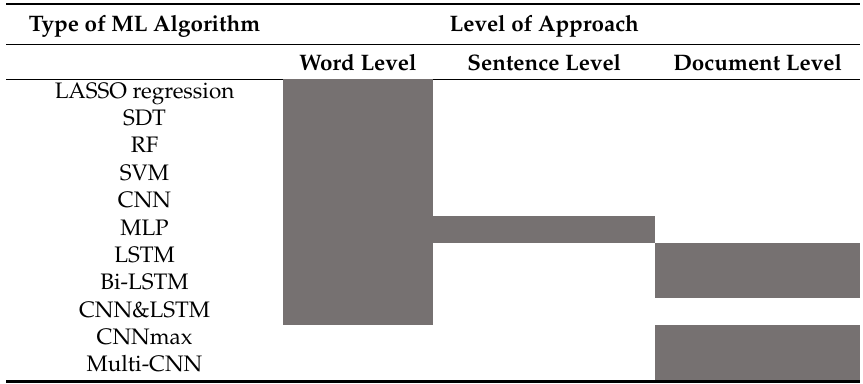
Table 1. Type of machine learning algorithm used in di ff erent level of natural language processing approach. The filled cell indicates the machine learning algorithm used. (ML, machine learning; LASSO, least absolute shrinkage and selection operator; SDT, single decision tree; RF, random forest; SVM, support vector machine; CNN, convolutional neural network; MLP, multilayer perceptron; LSTM, long short-term memory; Bi-LSTM, bidirectional LSTM; CNN-Max, max-pooling CNN; Multi-CNN, multi-kernel CNN).